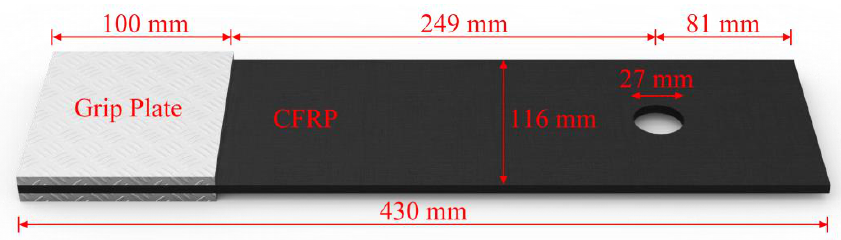
Figure 11. Diagrammatic sketch and geometry of the CFRP laminate specimen.